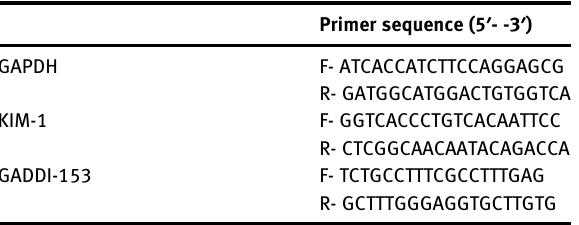
Table  : Primer sequences used for qRT-PCR in the study. Primer sequence (  ′ - -  ′